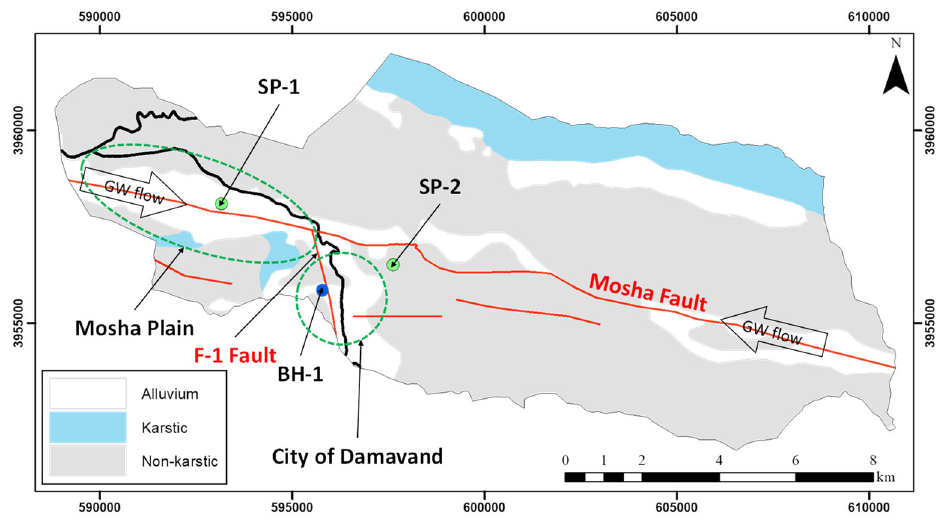
Figure 2. A map showing the karstic zones of the study area as well as the Mosha Fault and groundwater flow directions. Solid black lines represent major inter-city roads.